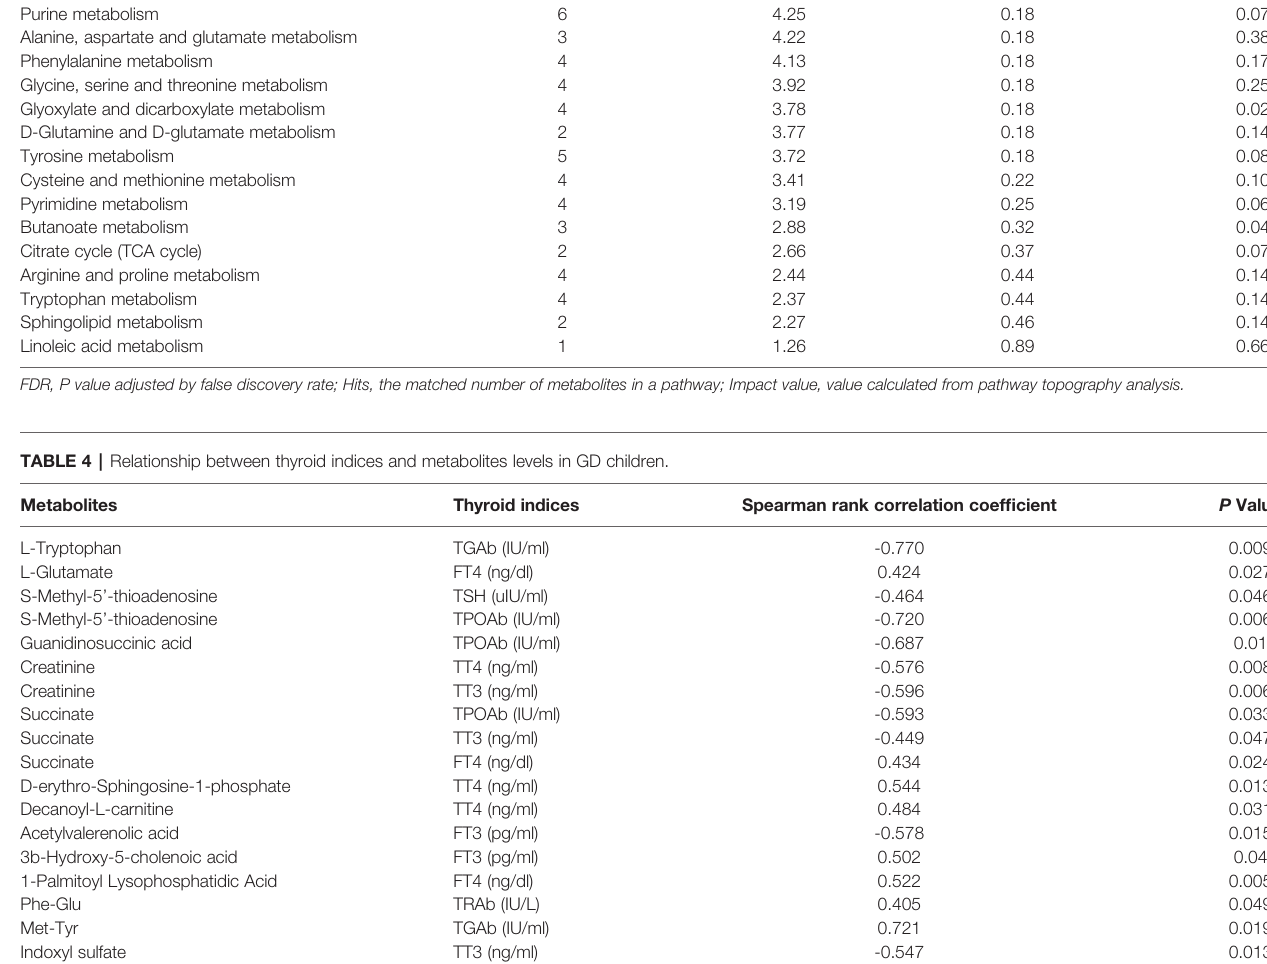
TABLE 3 | Differential pathways between the GD and control groups. Pathway Hits